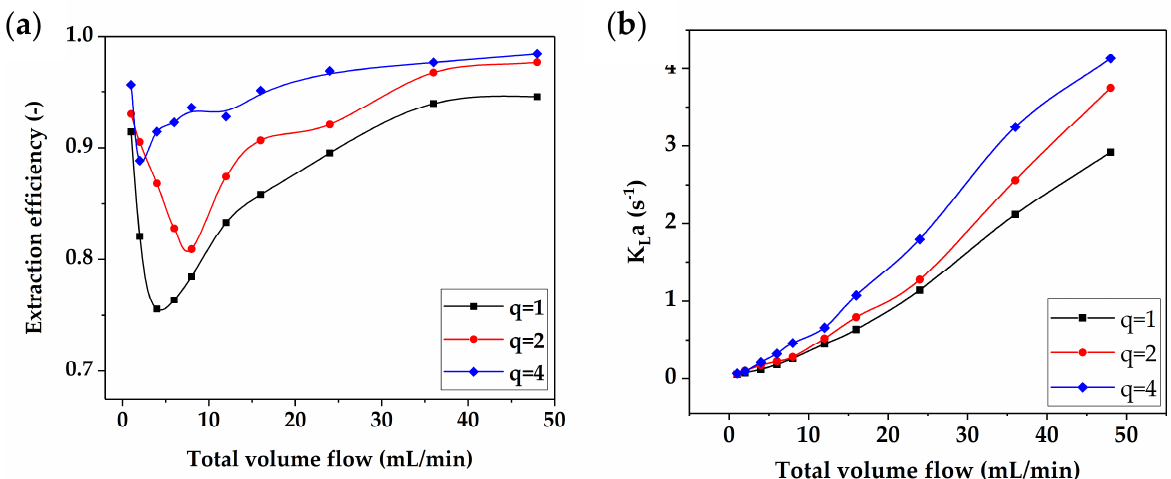
Figure 11. ( a ) Effect of flow rate on the extraction efficiency E and ( b ) volumetric mass transfer coefficient K L a .